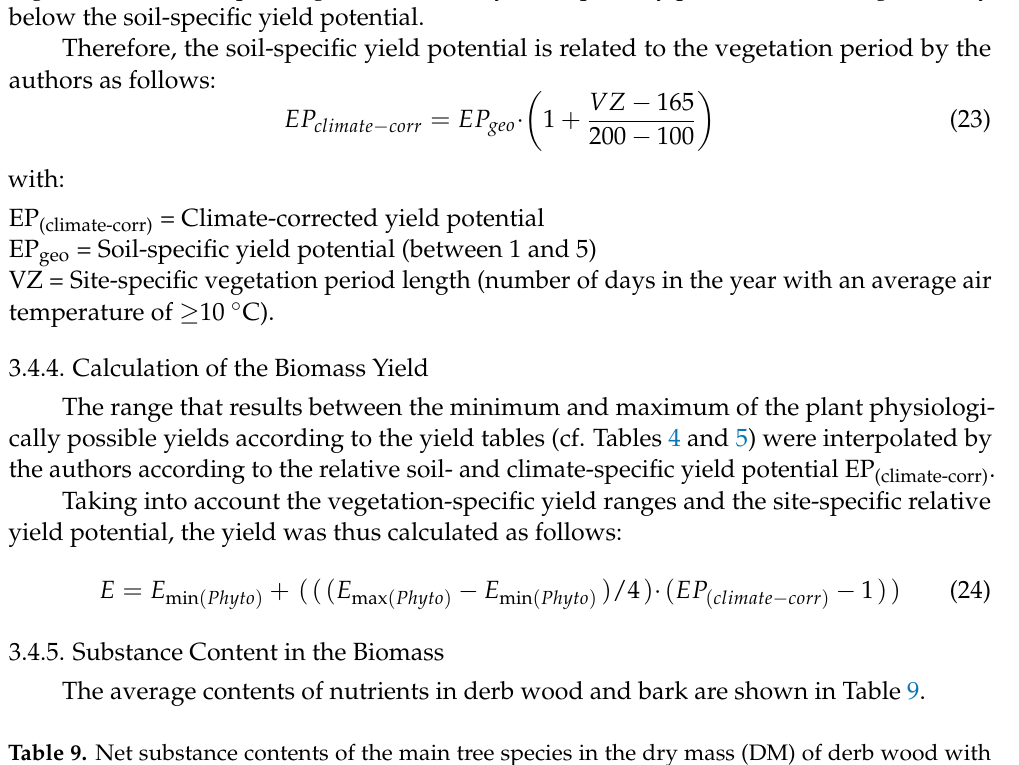
Table 9. Net substance contents of the main tree species in the dry mass (DM) of derb wood with bark [97,98].